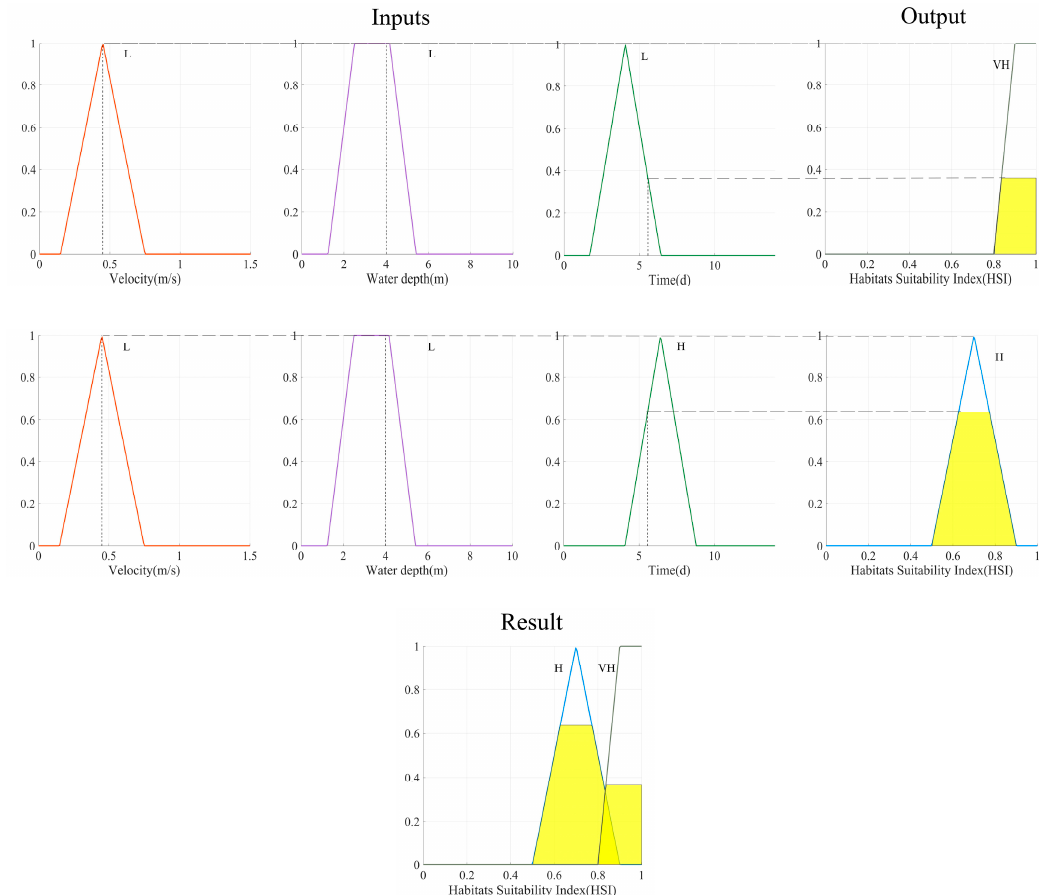
Figure 7. Illustration of the fuzzy inference process. Table 1. Fuzzy rule base representing the habitat suitability index (HSI) for the spawning of Ctenopharyngodon idella ( C. idella ).